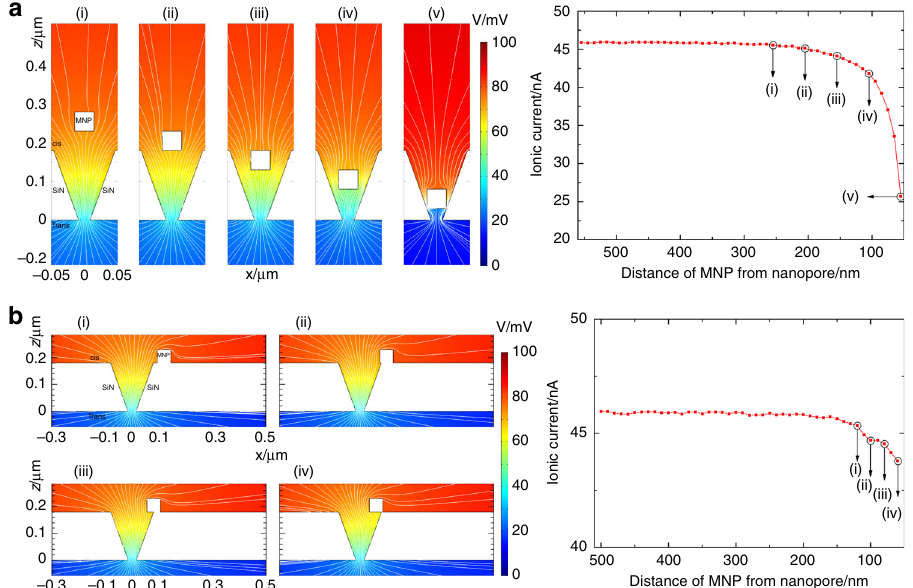
Fig. 3 Pathways for a 50 nm MNP entering into a 30 nm nanopore. Electric potential and fi eld distribution, as well as the corresponding approximated ionic currents as a function of distance related to the nanopore on a 180-nm-thick SiN membrane are present. a Direct entry. MNP is located at a distance of (i) 255 nm, (ii) 205 nm, (iii) 155 nm, (iv) 105 nm, (v) 55 nm away from the trans-side nanopore ori fi ce. White solid lines represent the electric fi eld lines in the electrolyte region. Approximated ionic current as a function of distance of the MNP from the trans-side nanopore ori fi ce. b Indirect entry. The MNP is located at a distance of (i) 120 nm, (ii) 100 nm, (iii) 80 nm, (iv) 60 nm away from centre axis of the cis-side nanopore ori fi ce. Electric potential distribution is colour coded in Volt (0~100 mV). White solid lines represent the electric fi eld lines in the electrolyte region. Approximated ionic current as a function of distance of MNP from the centre axis of the cis-side nanopore ori fi ce exit the pore. Two main forces act on the MNPs: the magnetic Fig. 3b. Here the magnetic force drives the MNP to the force from the cis-/trans - magnet and the electrophoretic force. membrane adjacent to the pore, where it is then attracted The magnetic force acts globally with uniform strength along the towards the pore along the x-y plane by the electrophoretic force. z -direction (positive z for cis- and negative z for trans-). In The COMSOL model predicts a rapid decrease in ionic current contrast, the electrophoretic force decays with increasing distance for ‘ direct entry ’ (Fig. 3a), since the MNP is rapidly driven from the pore and acts somewhat radially, i.e., it can have directly into the pore by the combined magnetic and electro- signi fi cant x- and y- components. The two forces combine to give phoretic forces acting together along the path. The MNP will bind multiple pathways to enter the pore, but a single pathway for exit. close to the pore constriction producing a higher Δ I. The indirect A small number of MNPs will take the direct entry path in Fig. 3a. path gives a smaller Δ I and a slower decrease in ionic current. The The more common alternative is the indirect entry path shown in former because the MNP will more likely bind to an anti-PSA NATURE COMMUNICATIONS| (2019) 10:2109